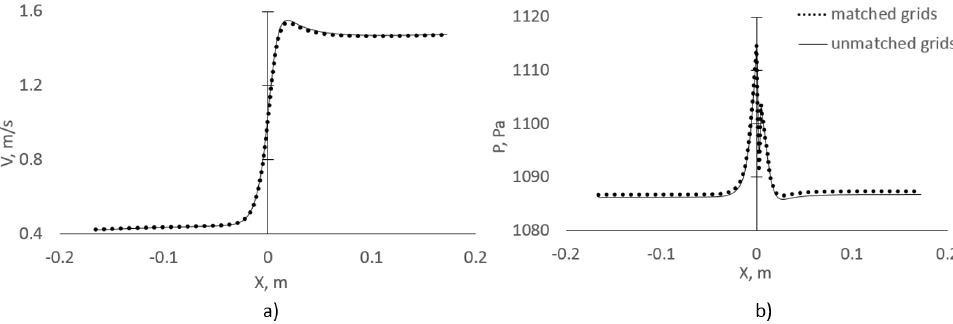
Figure 11. Profile along the channel: ( a ) velocity module, ( b ) pressure.